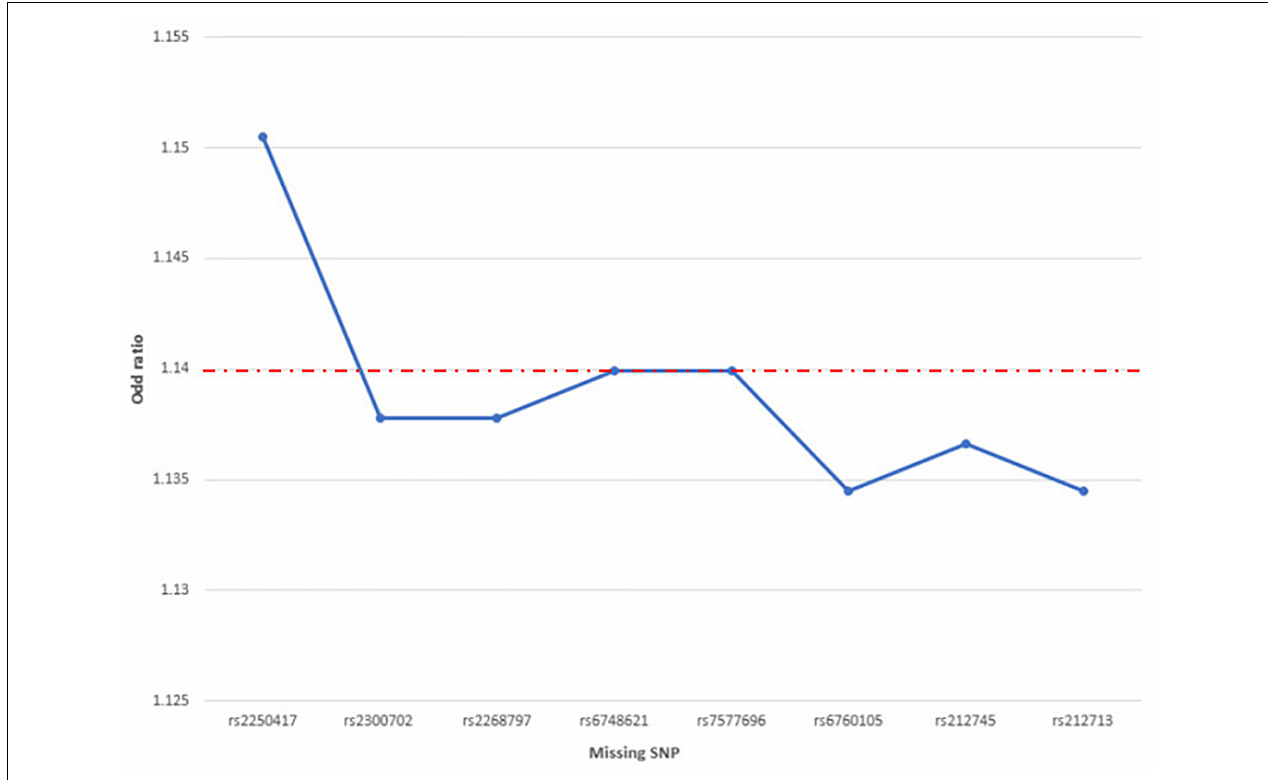
FIGURE 4 | Scatter plot of the ORs from IL-18-associated SNPs in the “leave-one-out” analysis. The red baseline shows the results without missing any SNP; the blue dots denote the results after removing one